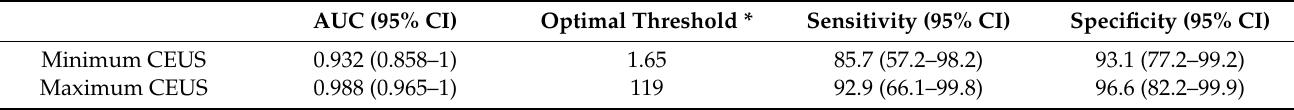
Table 3. CEUS as a marker of